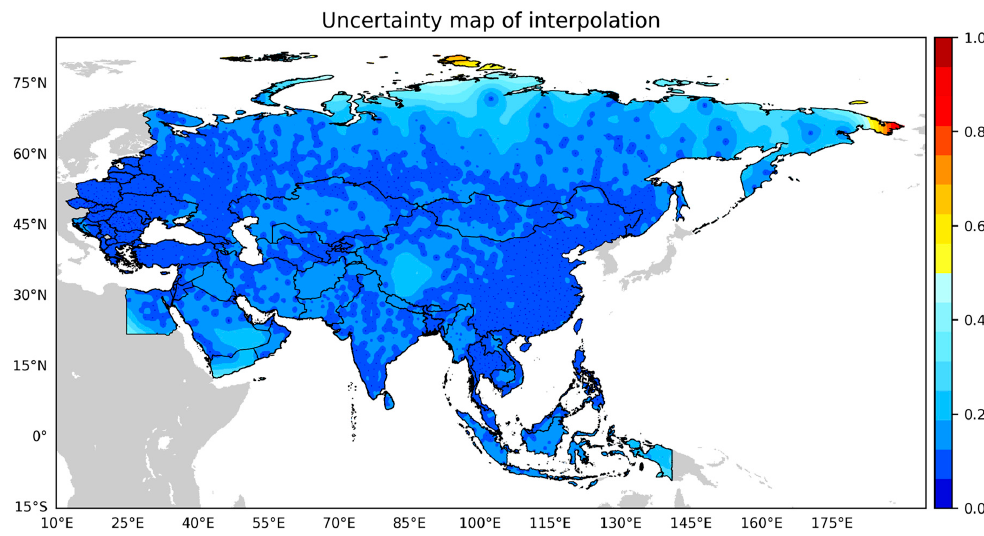
Figure 2. Uncertainty map of interpolation.